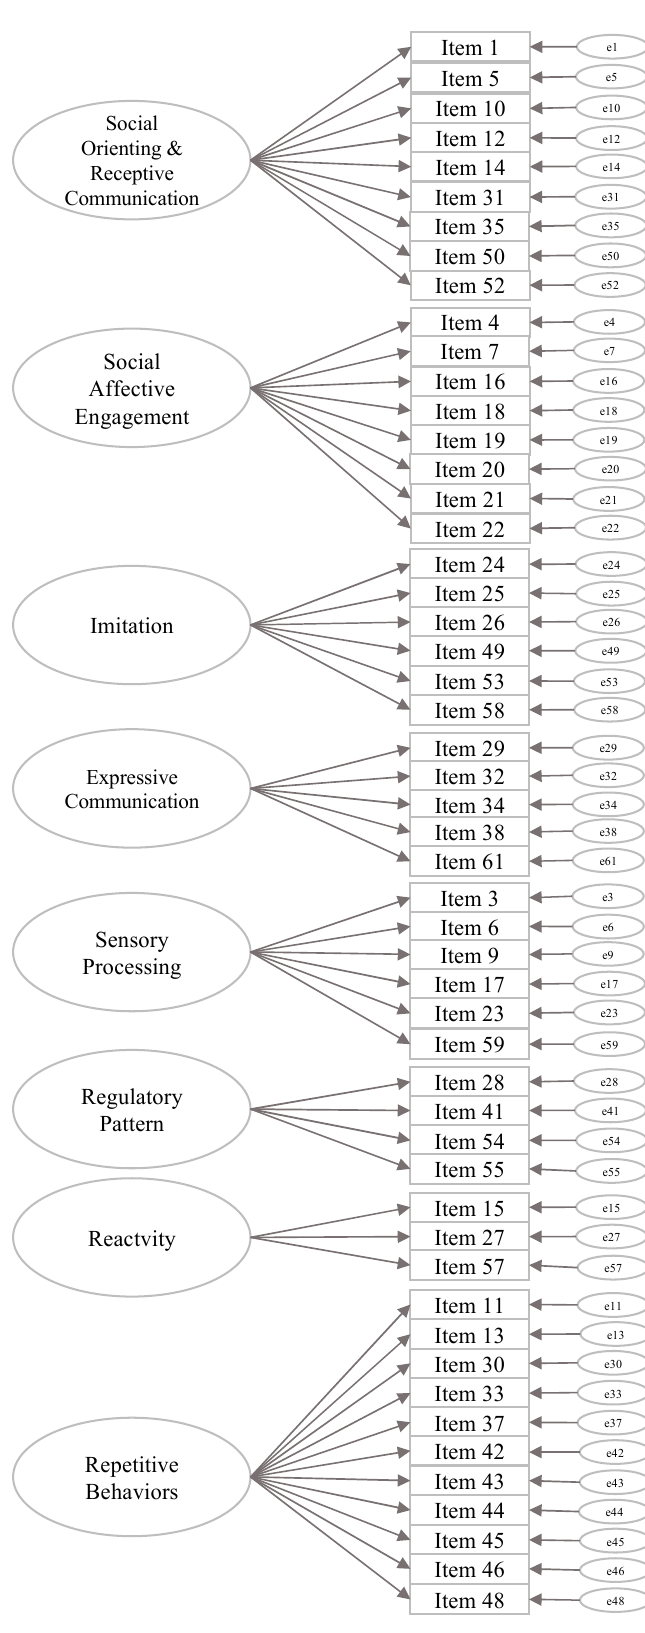
Figure 3. A graphical reproduction of FYI Factor Structure by Reznick et al. (2007).